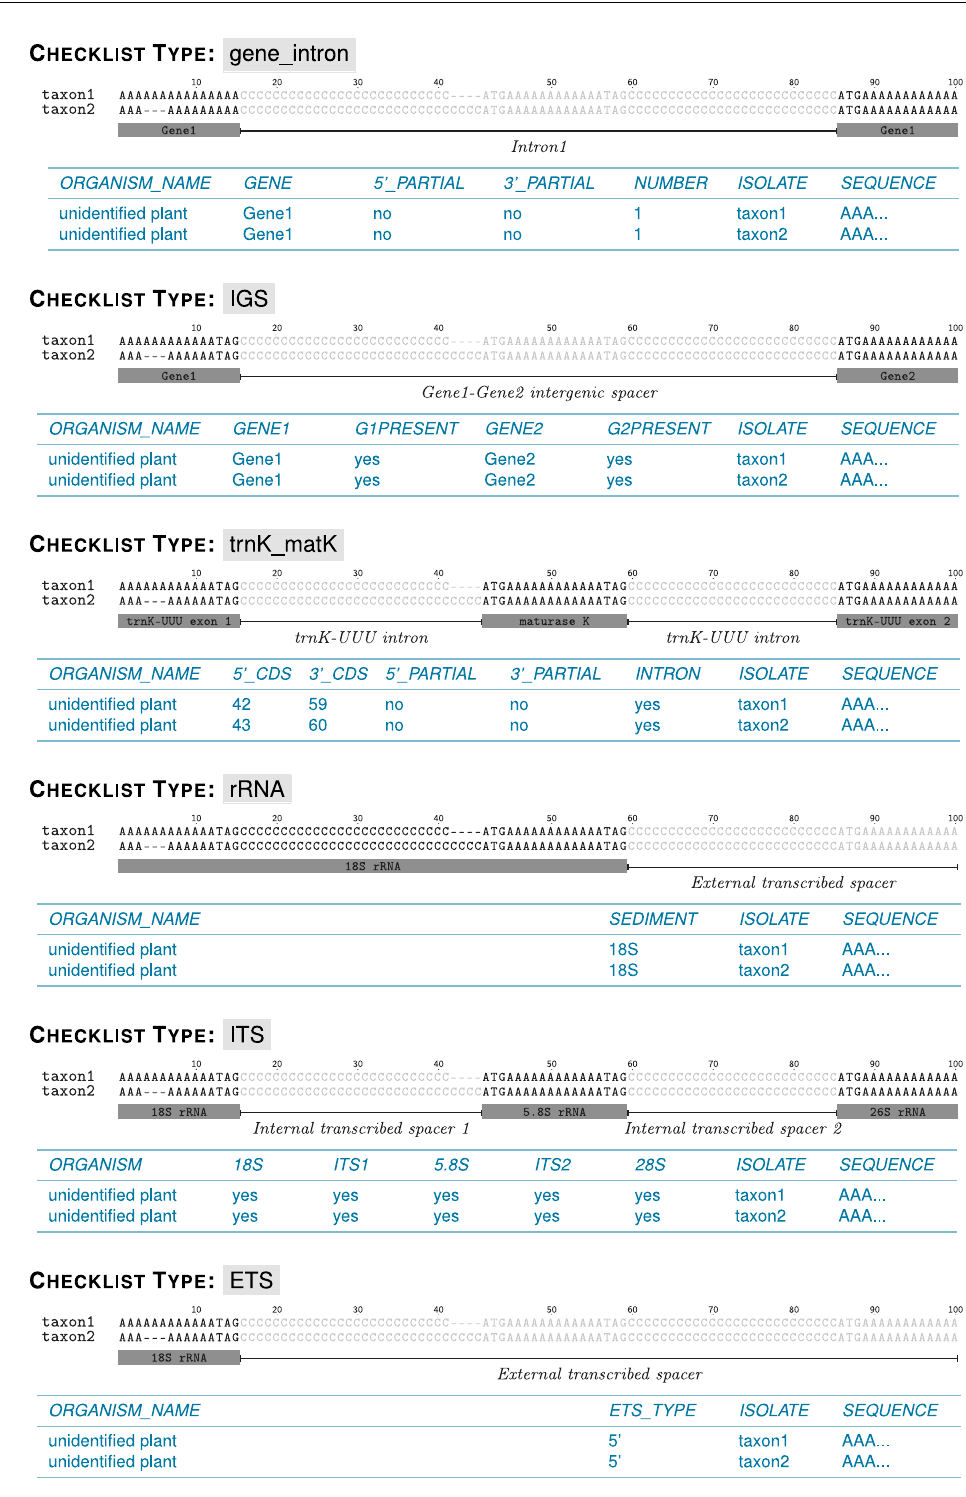
PLOS ONE | https://doi.org/10.1371/journal.pone.0210347 January 10,